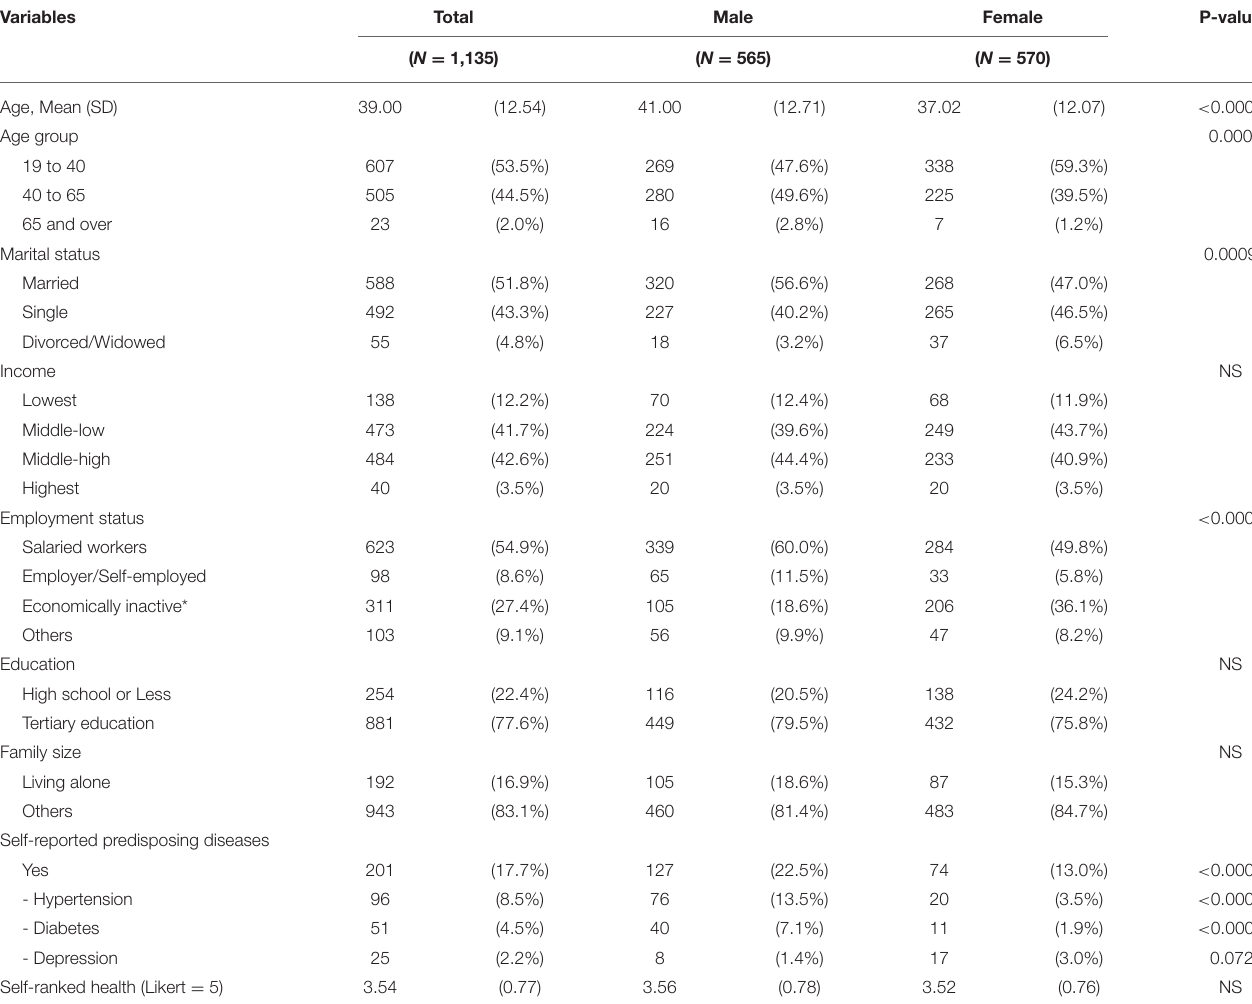
TABLE 1 | Baseline characteristics of the study